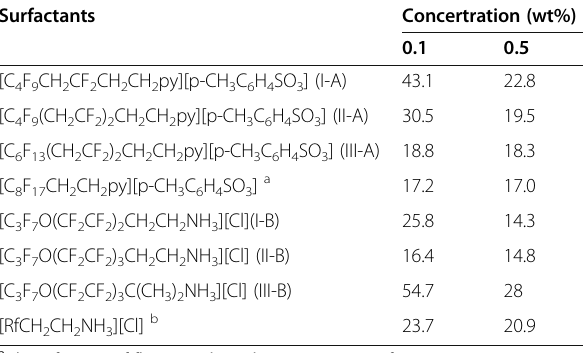
Table 3 Surface tensions (mN/m) of fluorinated pyridinium and ammonium cationic surfactants in deionized water at 23 °C [79] Surfactants Concertration